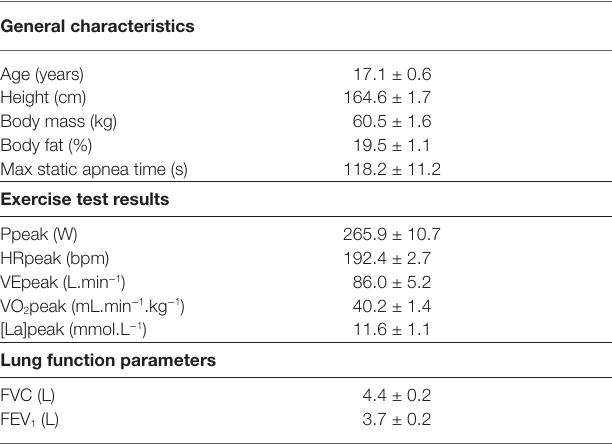
TABLE 1 | Anthropometric and training characteristics, lung function parameters, and maximal incremental test parameters (mean ± SE). General